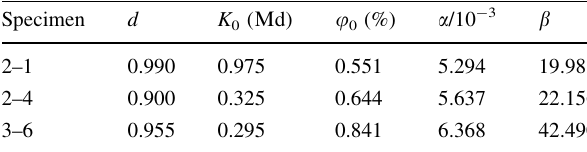
Table 3 Parameters of rock sample in Eq. (22) Specimen